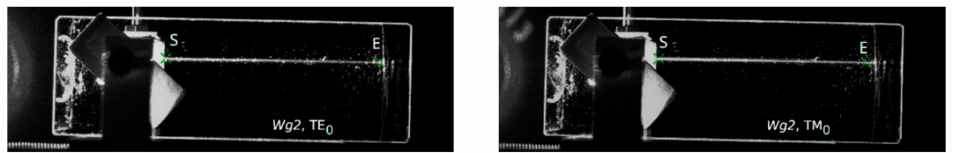
Figure 8. Streaks of scattered light accompanying propagation of TE 0 and TM 0 modes in the Wg2 waveguide. The endpoints (S and E) of scan lines are marked by a green cross.